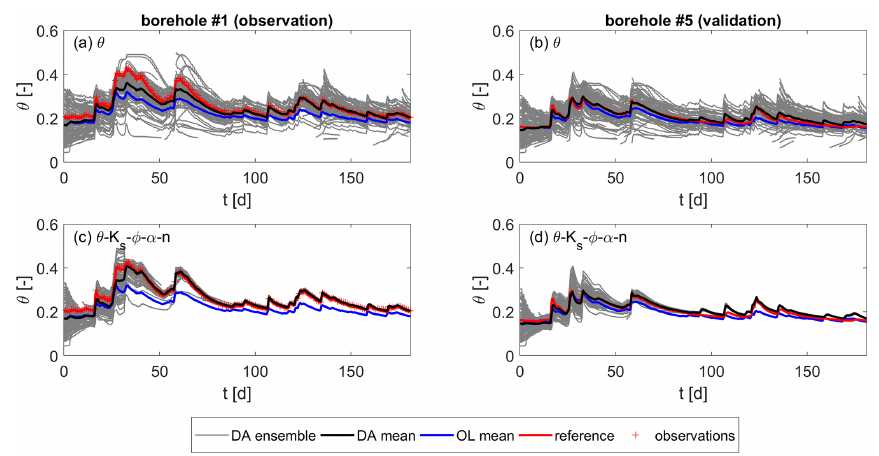
Figure 4. Soil moisture over time for the homogeneous scenario. Values are taken at one observation and one validation location, each at z 1 = 0 . 33m below the surface. (a, b) Updates of soil moisture only. (c, d) Joint updates of soil moisture and all parameters.